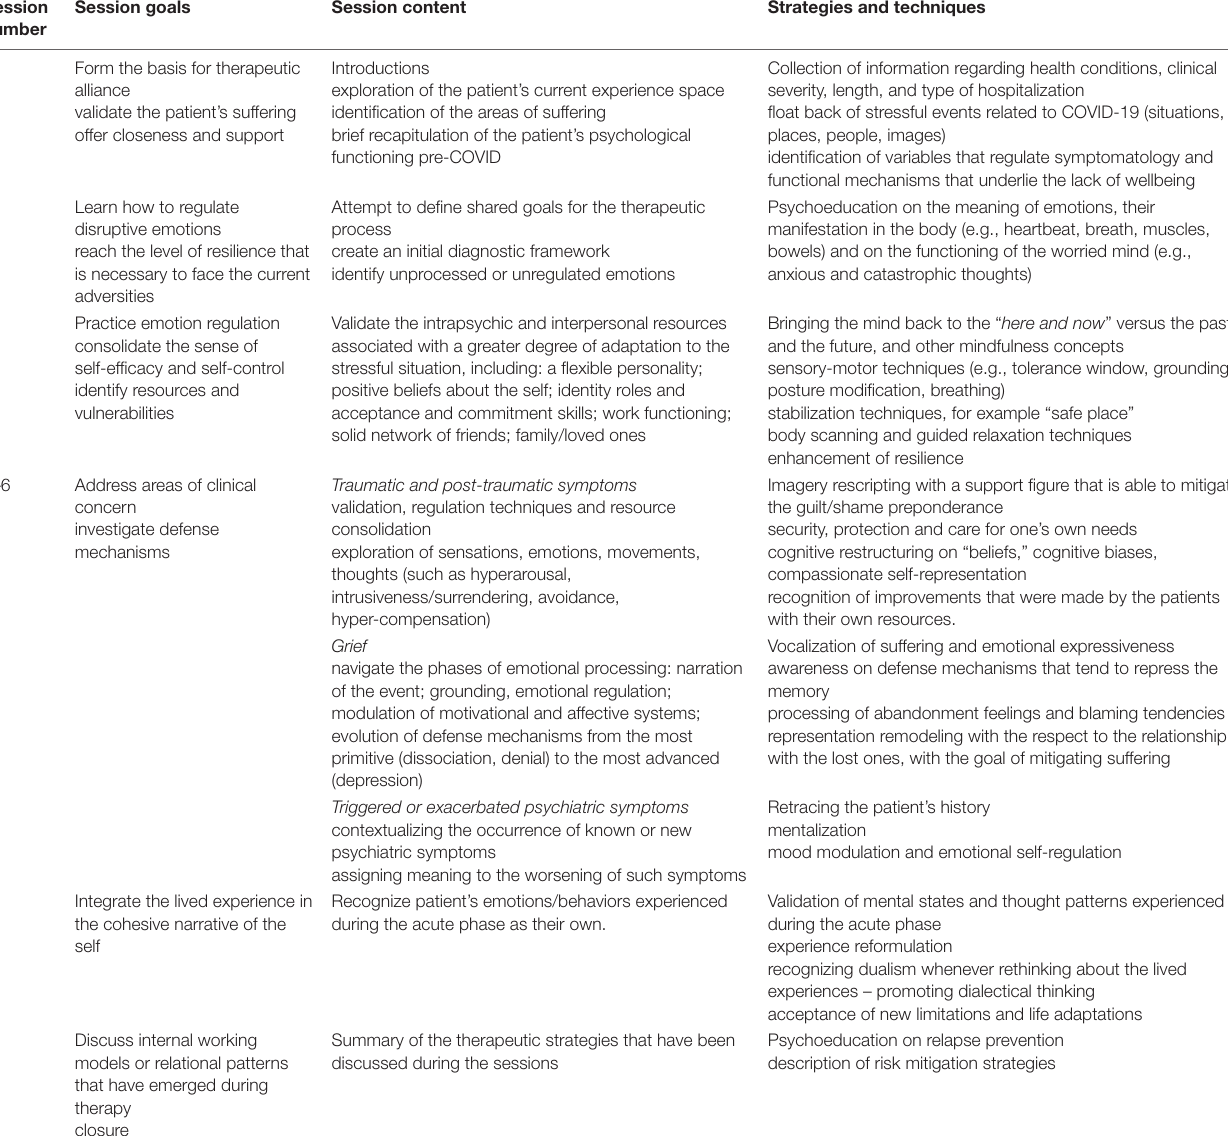
TABLE 3 | Goals, content, strategies, and techniques used in each session of the psychotherapeutic program. Session Session goals Session content Strategies and number